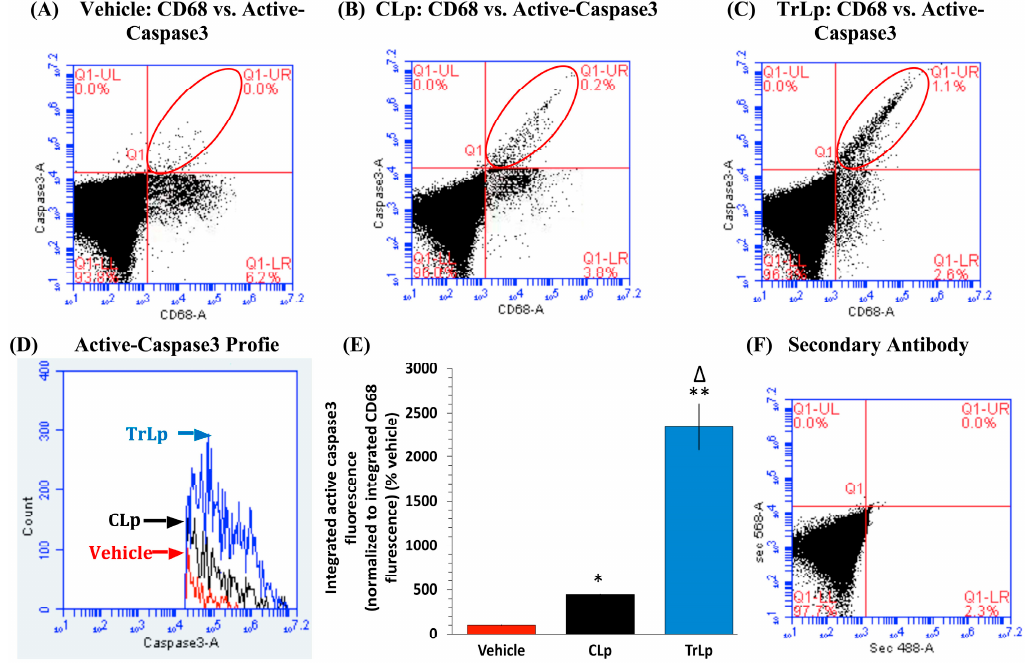
Figure 3. TrLp is significantly more potent than CLp in causing activation of caspase3 in CD68(+) GL261 cells. Flow cytometry analysis of treated-GL261 cells showed two discrete populations of GL261 cells: CD68+ and active-caspase3+ (double-stained cells) (apoptotic) enclosed within red ellipses in